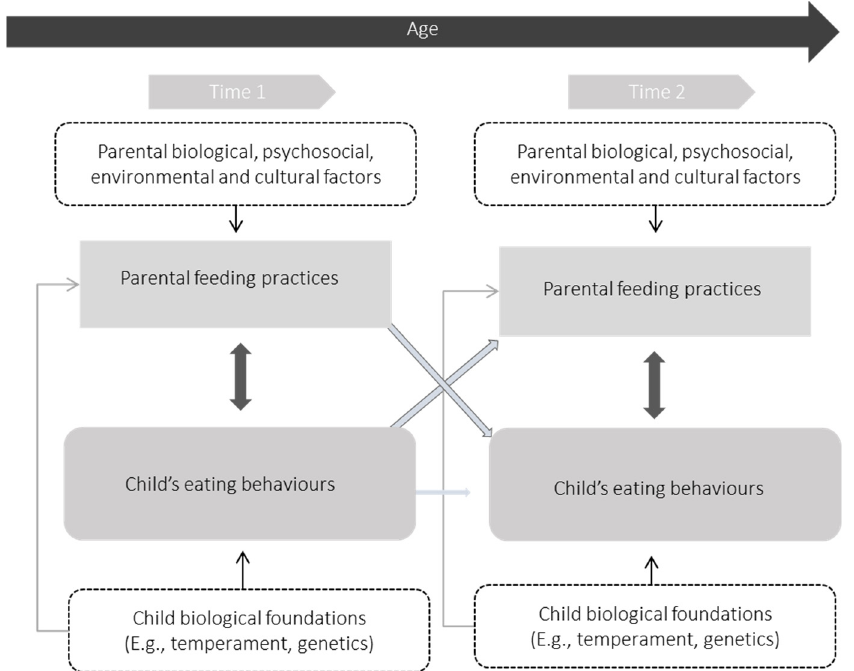
Figure 1. A model of biological and psychosocial processes in the early development of child’s eating behaviours. Adapted from Russell and Russell, 2018 and Russell and Russell, 2019 [10,100].